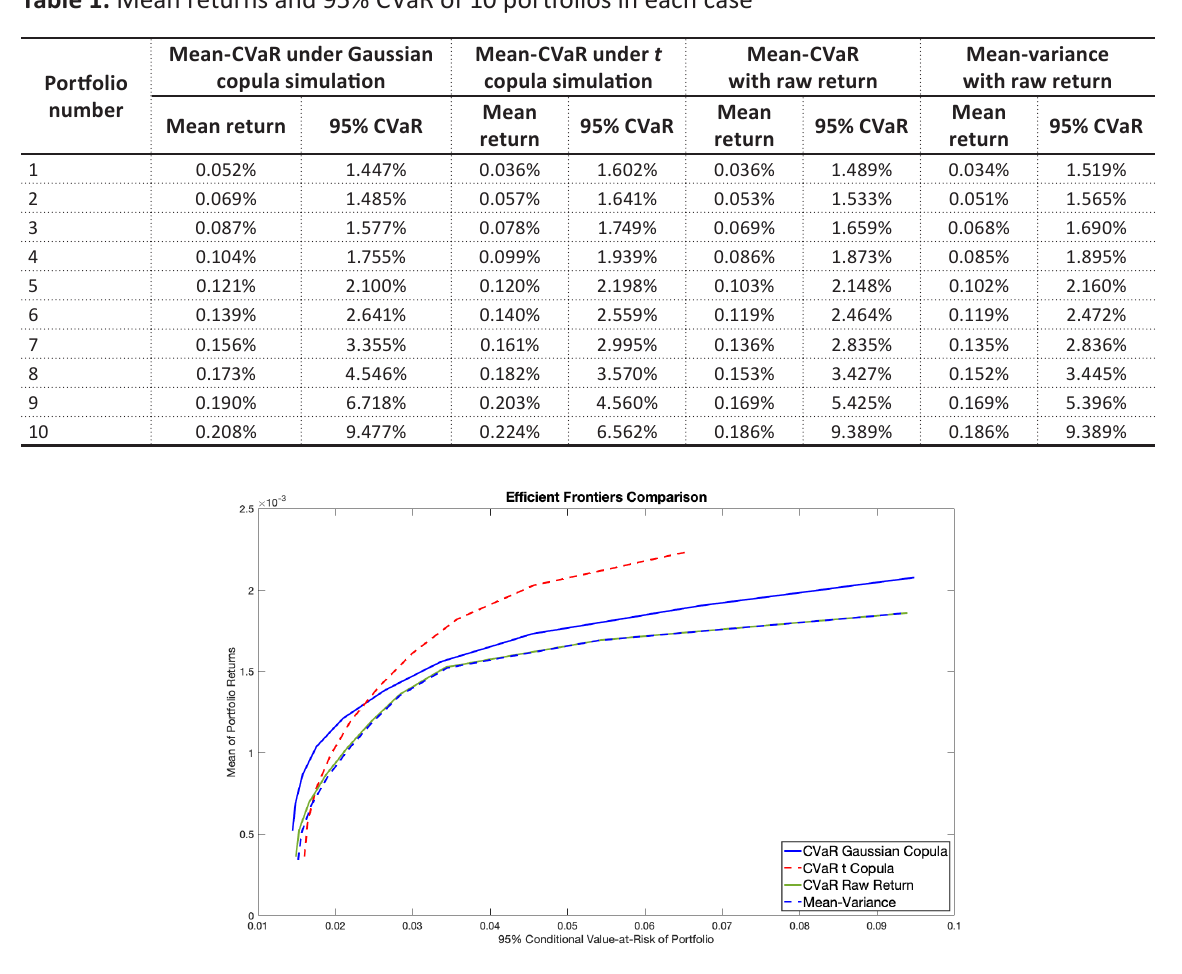
Figure 1. Mean-CVaR efficient frontiers with the 95%